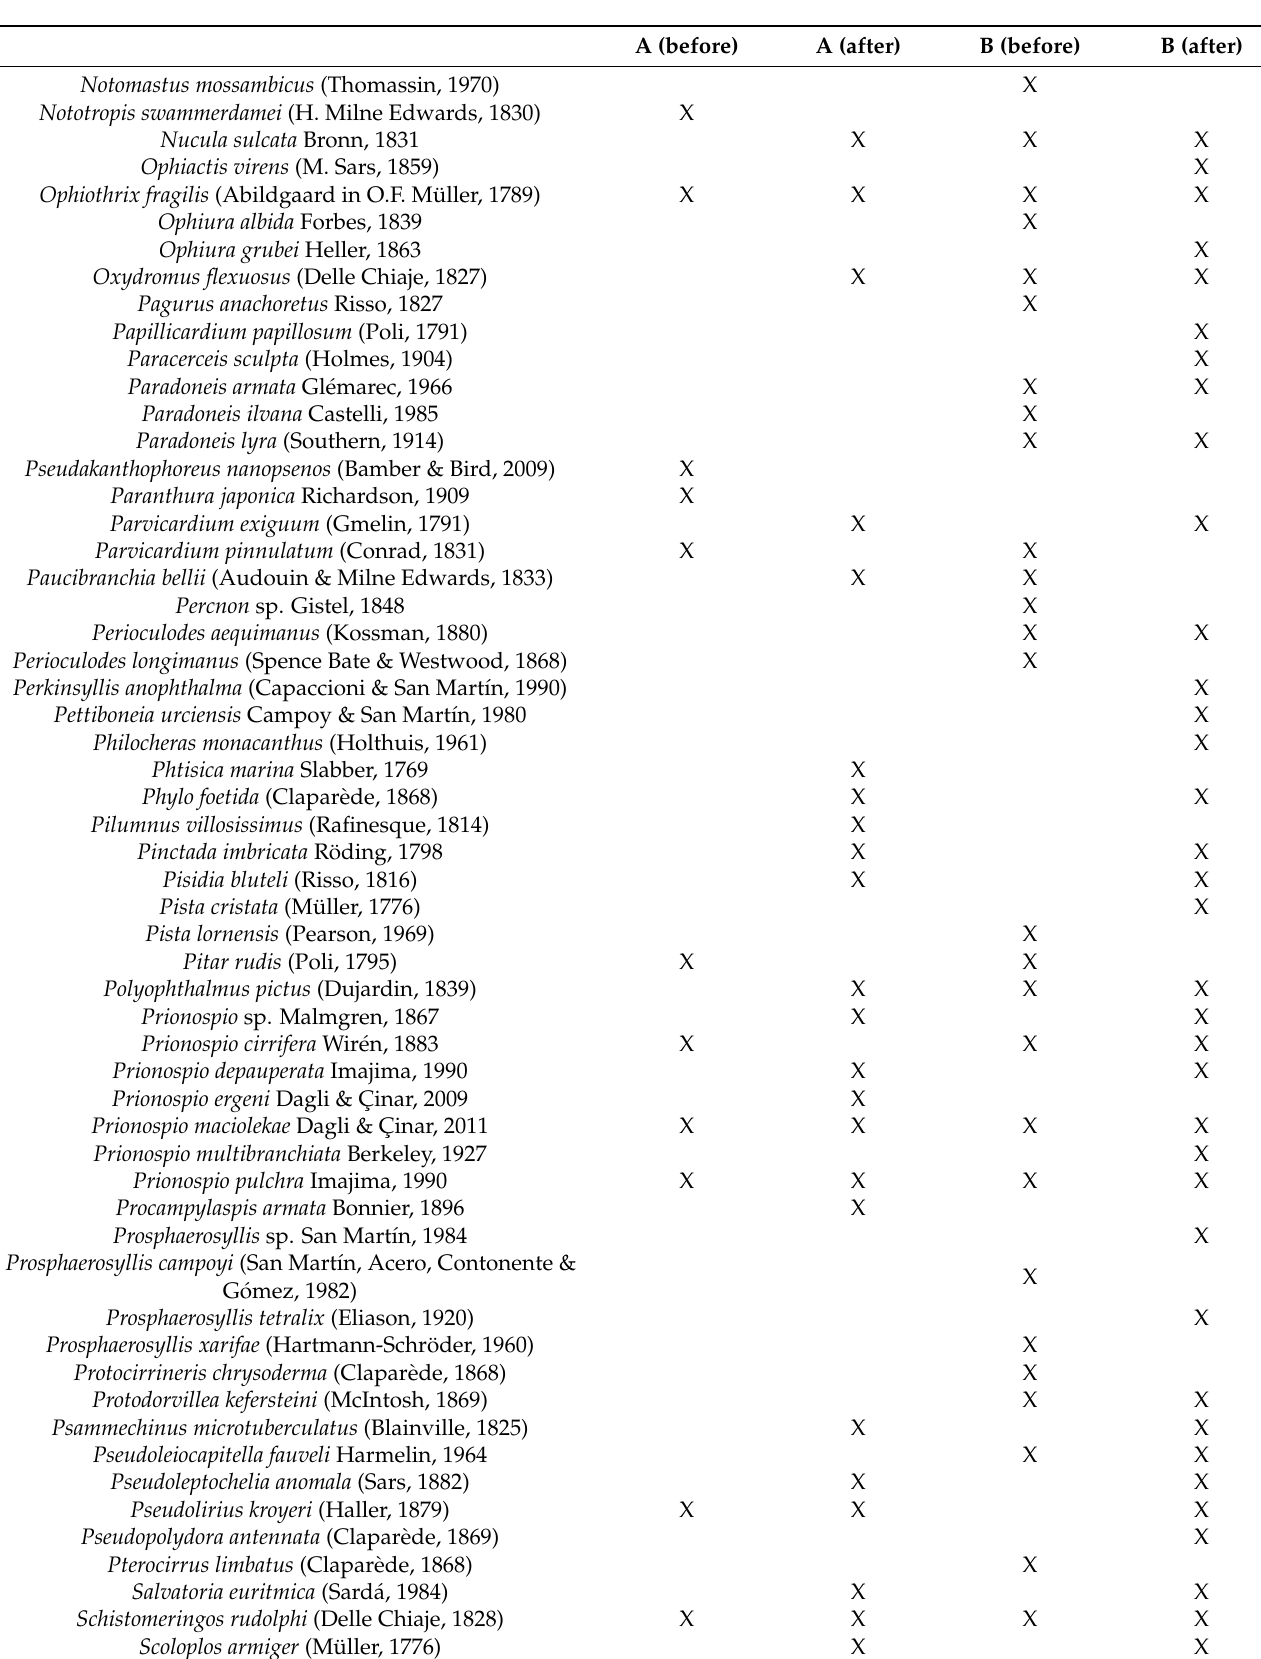
Table A1. Cont. A (before) A (after) B (before) B